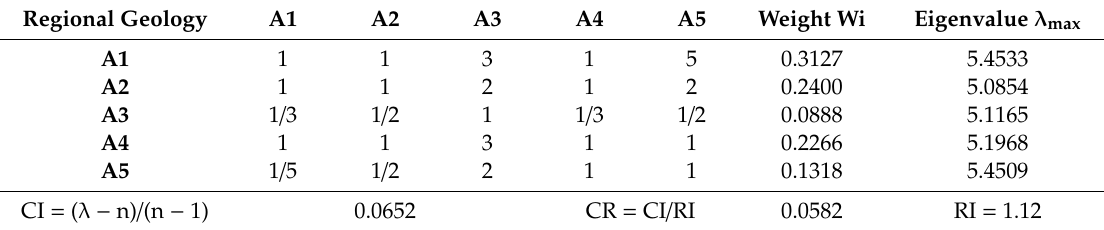
Table 5. A single sequence of the regional geology and consistency test.